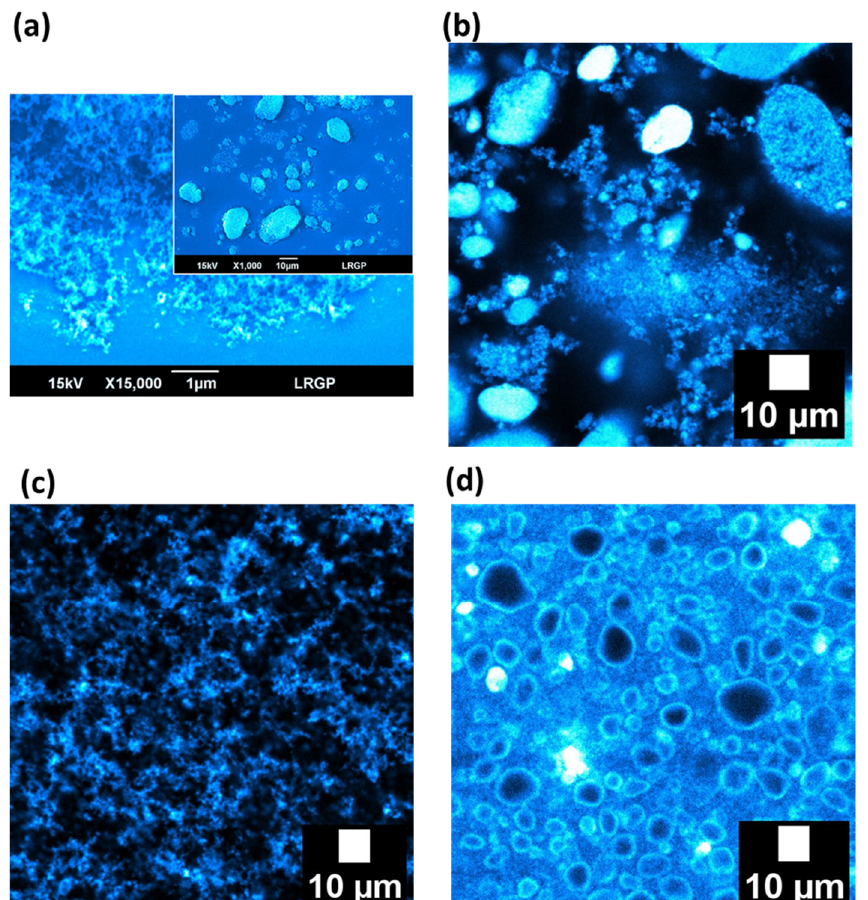
Figure 2. Scanning electron microscopy of ( a ) dry silica particles. Confocal fluorescence images of suspensions of silica particles in ( b ) dodecane, ( c ) paraffin oil and ( d ) water. The concentration of silica particles is 4 wt.%. Particles are represented in blue.